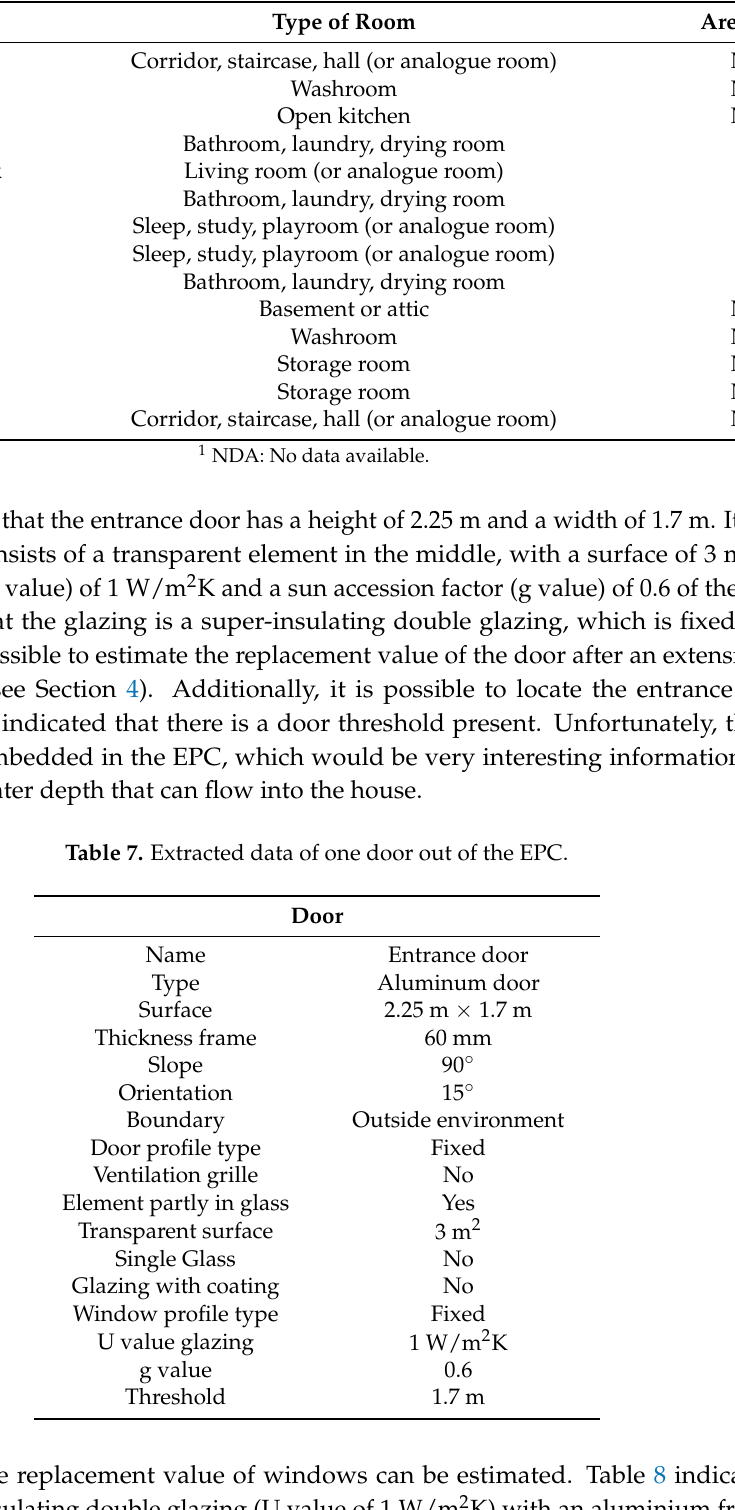
Table 6. Extracted types of functions and accompanying dimensions of rooms out of EPC document.